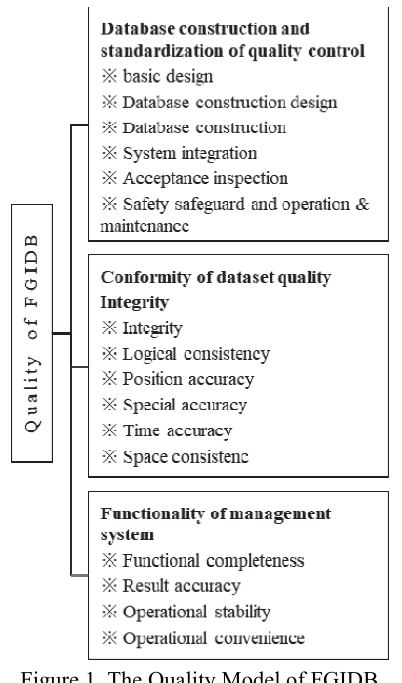
Figure 1. The Quality Model of FGIDB